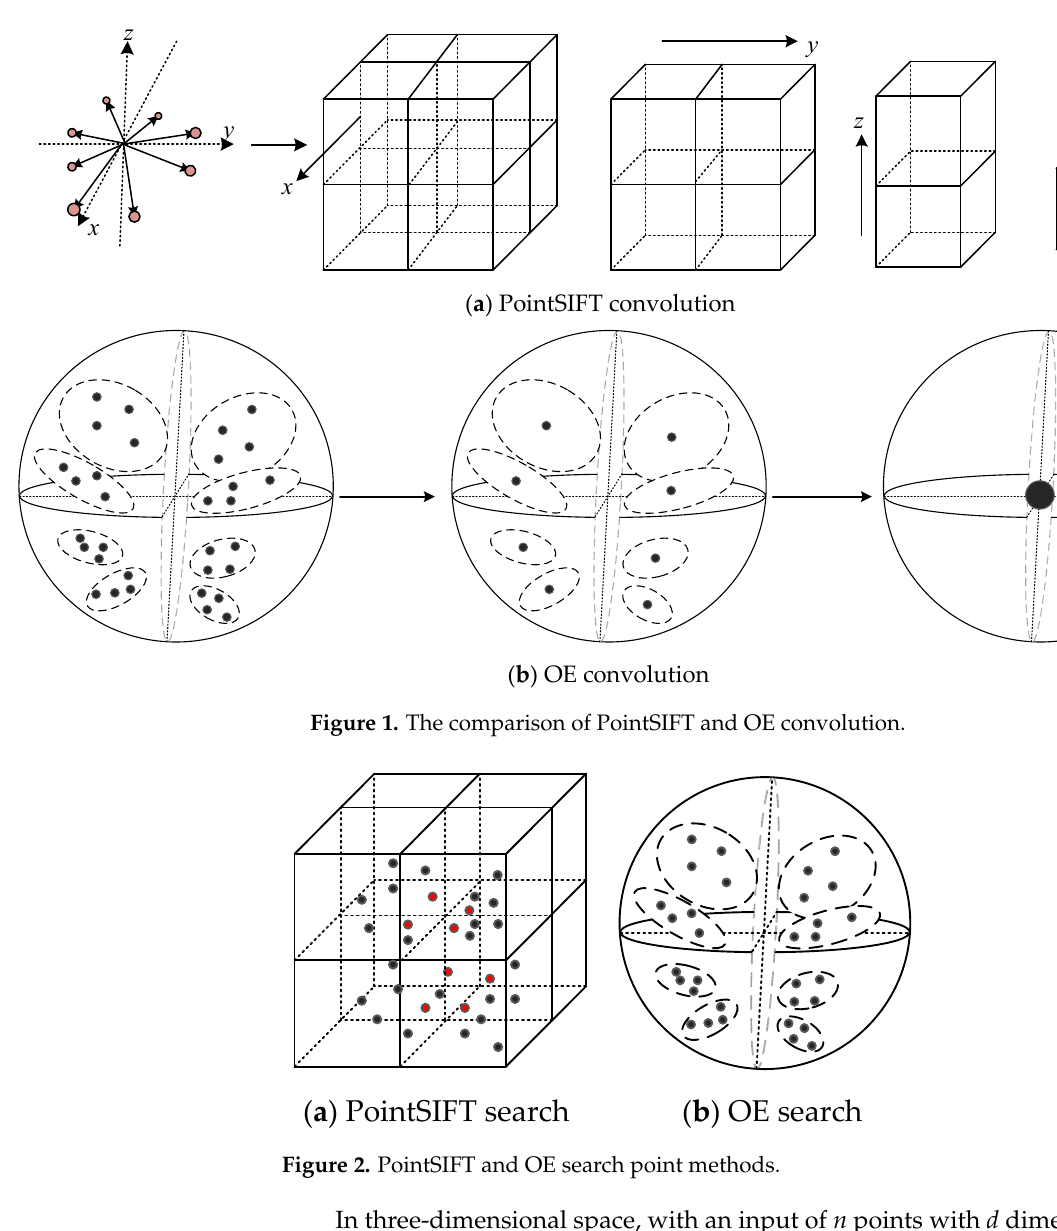
Figure 2. PointSIFT and OE search point methods.